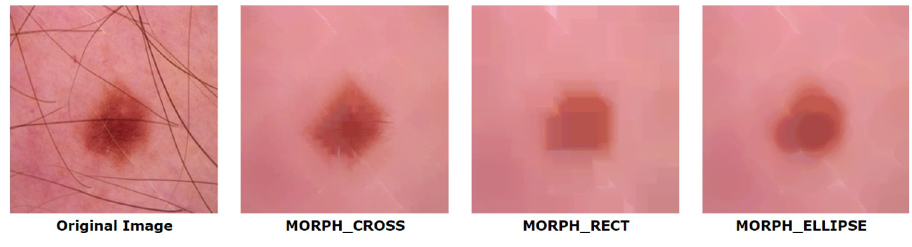
Fig 6. Resultant image of morphological closing with different kernel